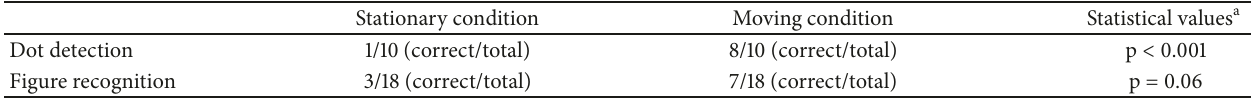
Table 2: Results of dot detection and figure recognition